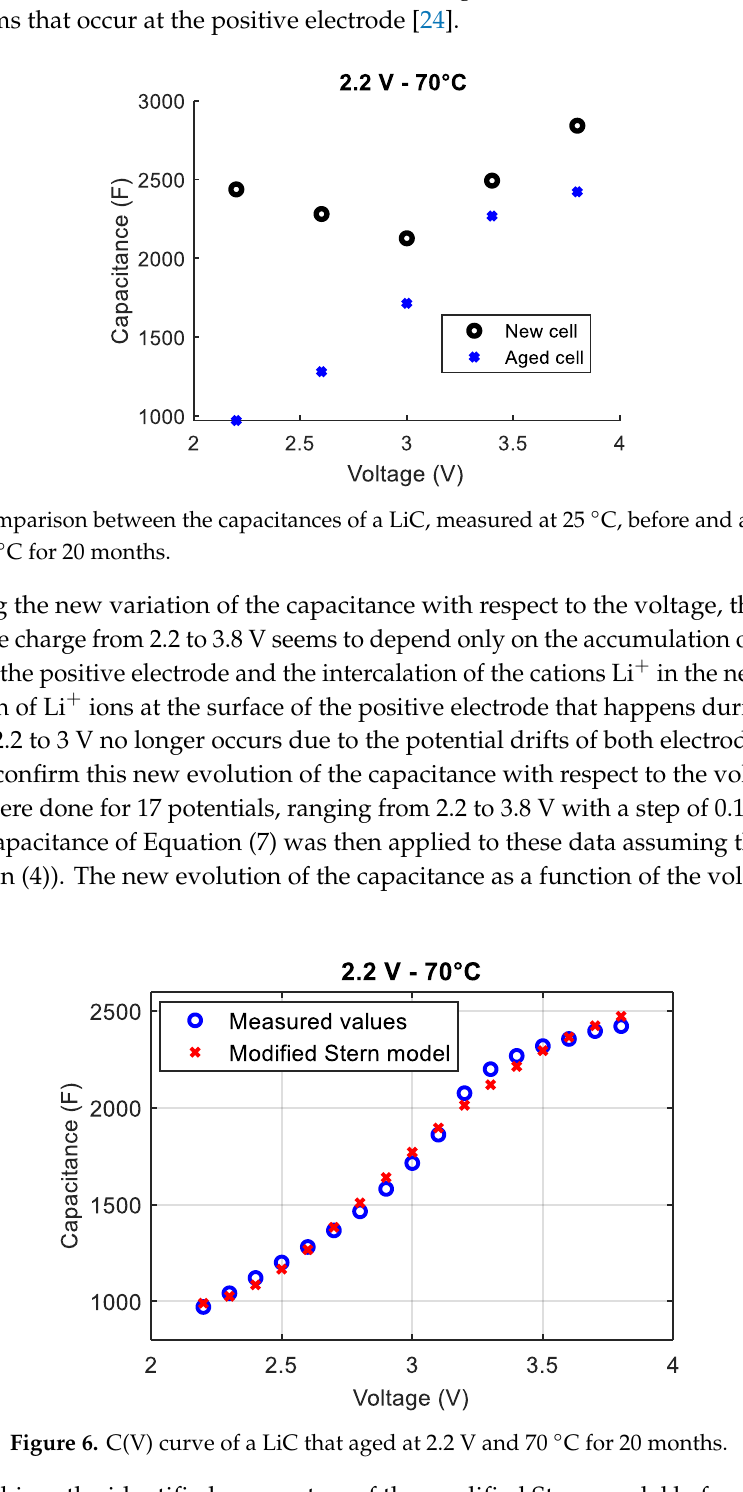
Figure 6. C(V) curve of a LiC that aged at 2.2 V and 70 °C for 20 months.